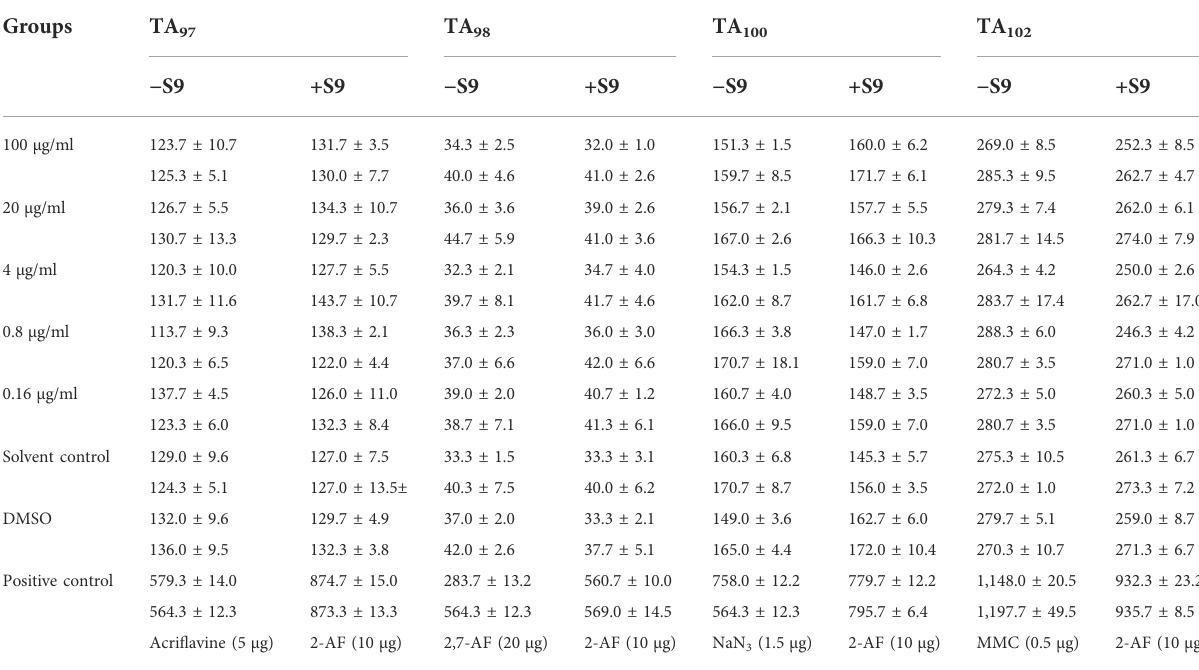
TABLE 6 Ames test results for MCE (Mean ±